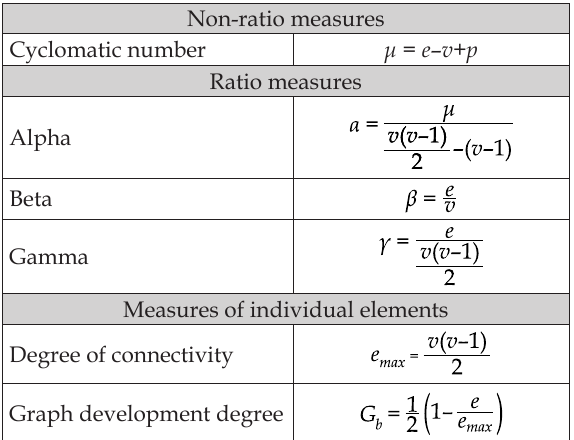
Table 1. Some measures of graph